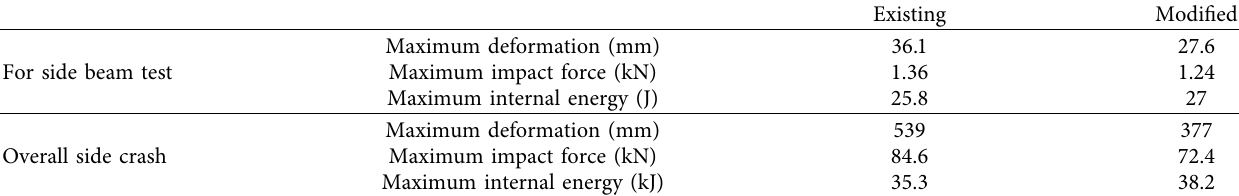
Table 5: Summary of the comparison between existing and modifed